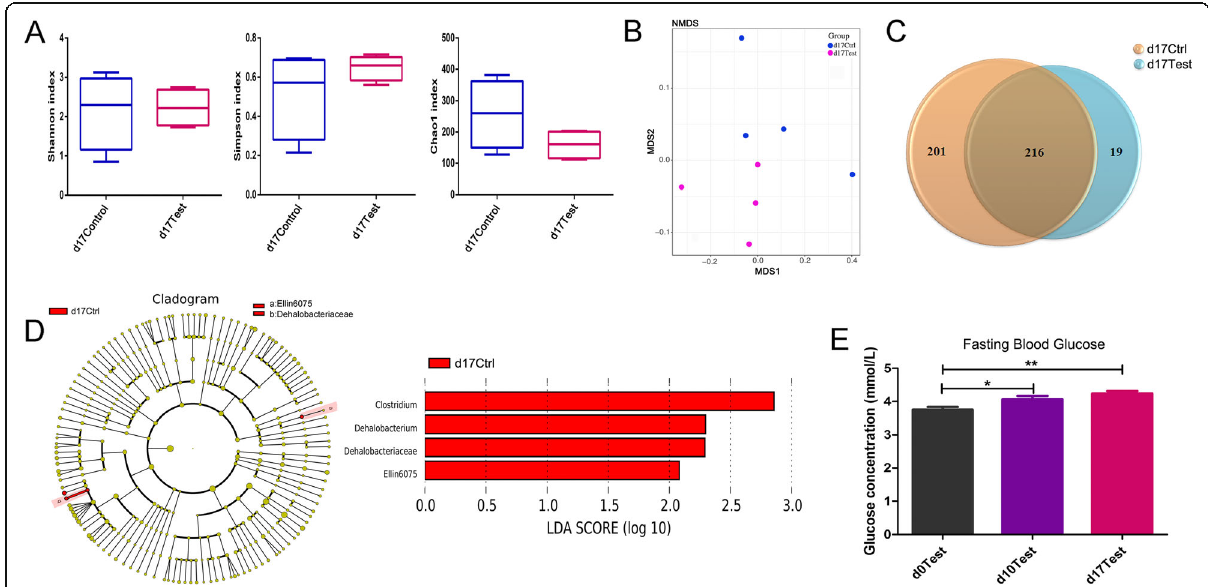
Fig. 5 Changes in the characteristics of gut microbiota between control rats and TiO 2 NP exposed rats at GD 17. a Shannon, Simpson, and Chao1 index which presented alpha-diversity were compared between two groups. b The beta-diversity was revealed by NMDS analysis. c The Venn diagram showing the unique and sharing OTUs in two groups. d Lefse found the candidate biomarkers (LDA > 2) and the differences of gene functions were predicted. e The fasting blood glucose levels of rats were measured at GD 0, GD 10, and GD 17 after exposed to TiO 2 NPs. D17 Ctrl and d17 Test means the control and exposed rats on the 17th day of pregnancy,